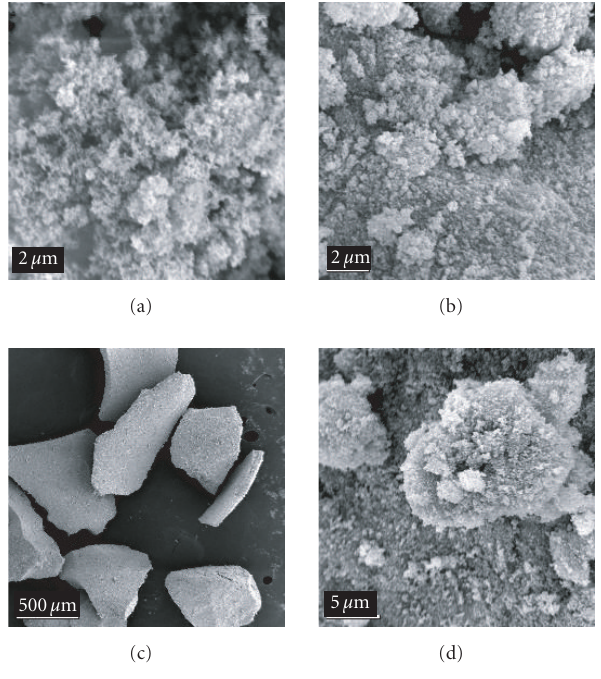
Figure 4: SEM pictures of TiO 2 P25 samples (a) and aggregates of TiO 2 particles (b), (c), and (d).